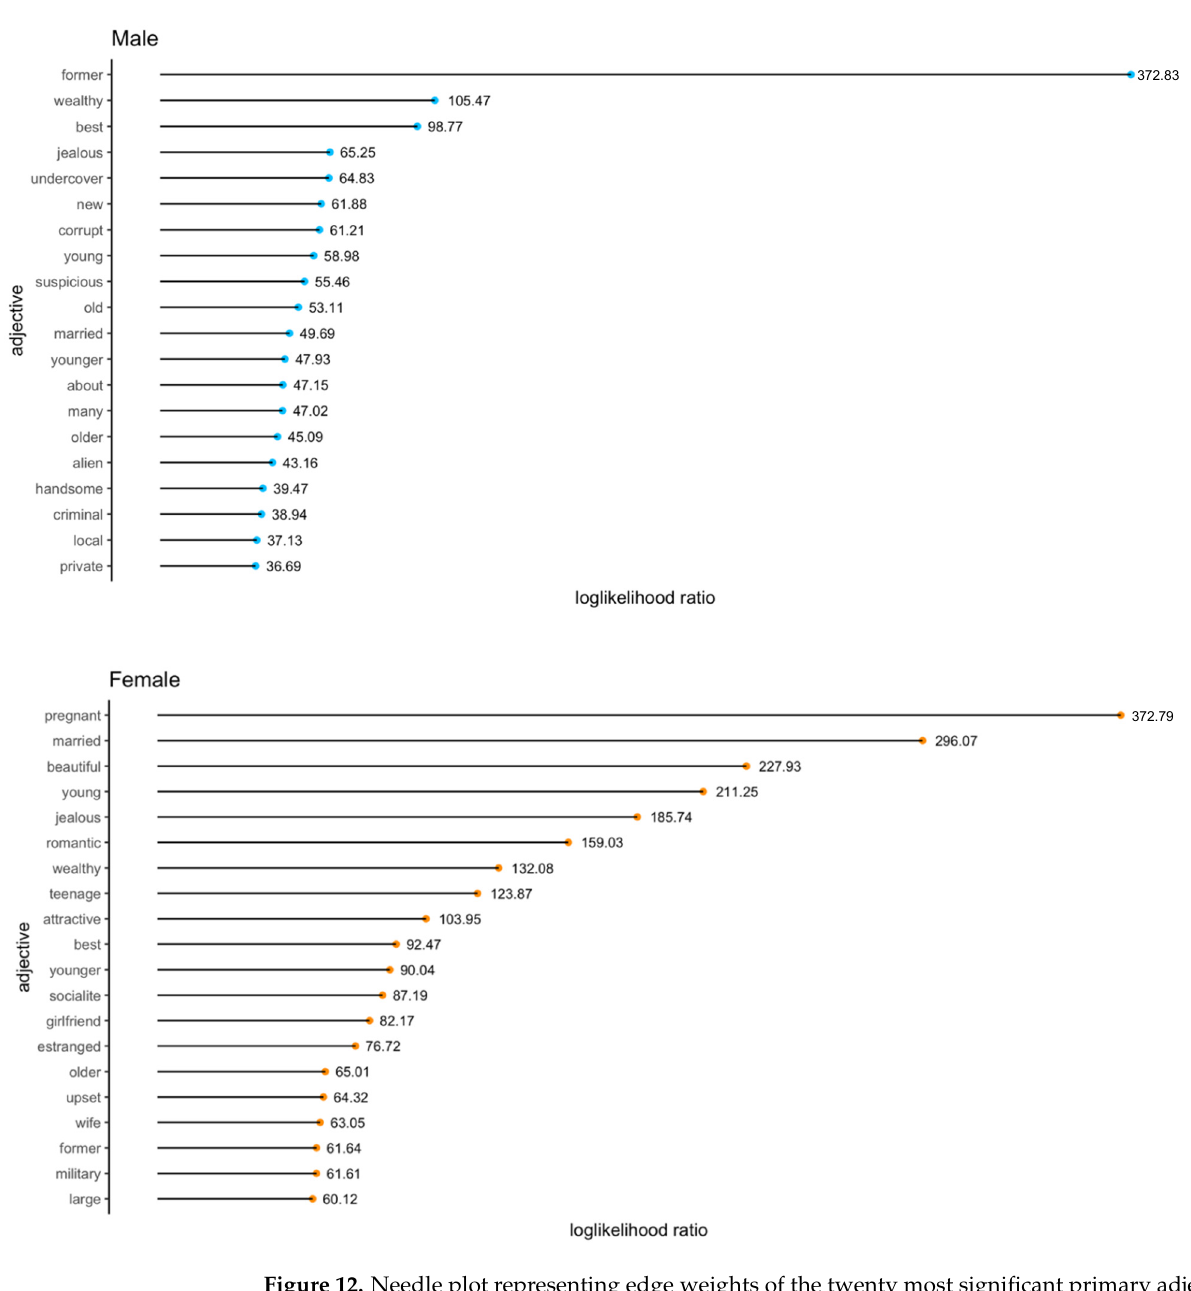
Figure 12. Needle plot representing edge weights of the twenty most significant primary adjective associations of male characters ( top ) and female characters ( bottom ).